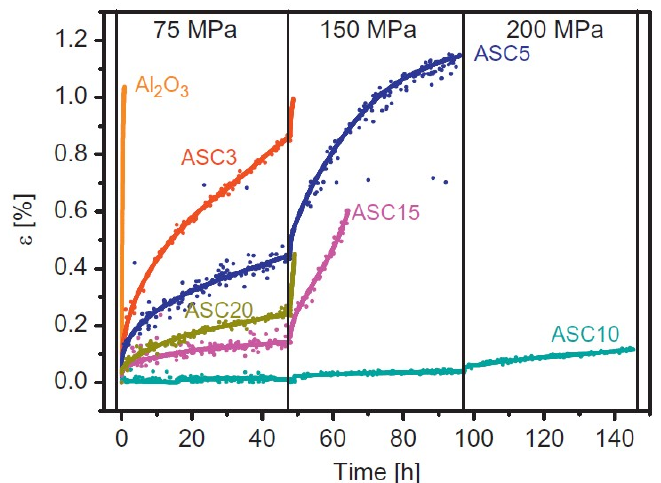
Figure 2. Creep deformation of Al 2 O 3 -SiC (AS) nanocomposites measured at 1350 °C and mechanical load of 75, 150, and 200 MPa. The increase of load is reflected as a break at the stress-strain curve. The number in the sample denomination represents the volume fraction of SiC in the material, i.e. , AS5c represents the Al 2 O 3 -SiC nanocomposite with 5 vol% of SiC